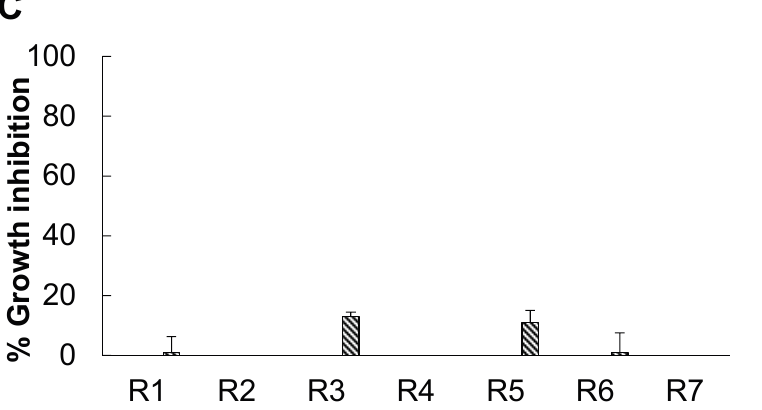
Figure 2. Antibacterial activity of the natural compounds in Robinia pseudoacacia against the tested bacteria. ( A ) Porphyromonas gingivalis ; ( B ) Streptococcus mutans ; ( C ) Escherichia coli DH5 α . The natural compounds included: R1, Acacetin; R2, Amygdalin; R3, Fisetin; R4, Taxifolin; R5, Myricetin; R6, Apigenin; R7, Rutin.